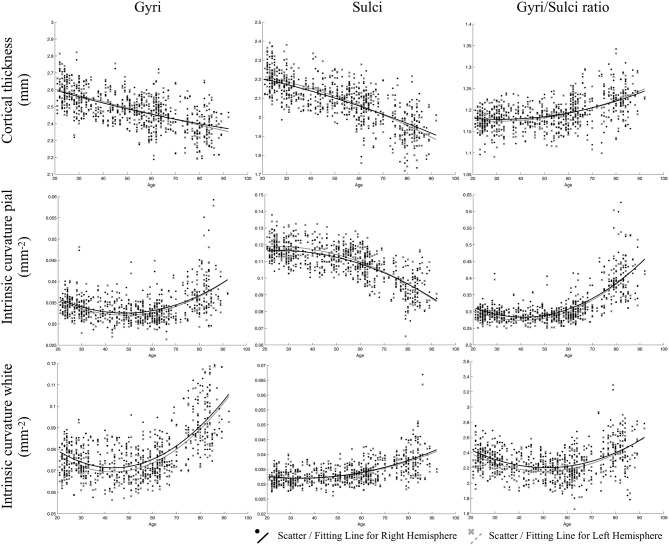
Results of the regressions of age with gyri, sulci, and the gyri/sulci ratio of cortical thickness and intrinsic curvature on the pial and white matter surfaces. The lines refer to the fitted curve for the age and measurements, and the dots indicate the distribution of that data for the subjects.